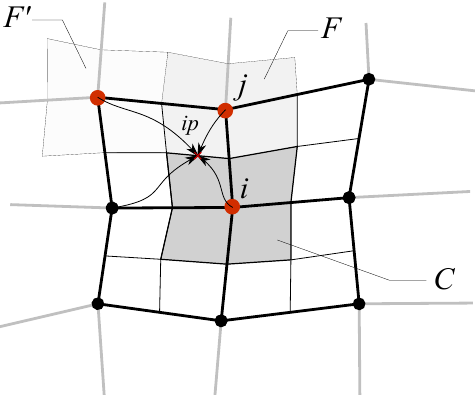
Figure 4. Extended portrayal of the CVFEM mesh showing the control volume C associated with the node of index i with any neighboring control volume F associated with a node of index j . F (cid:48) is another neighboring control volume but does not share any integration point with C